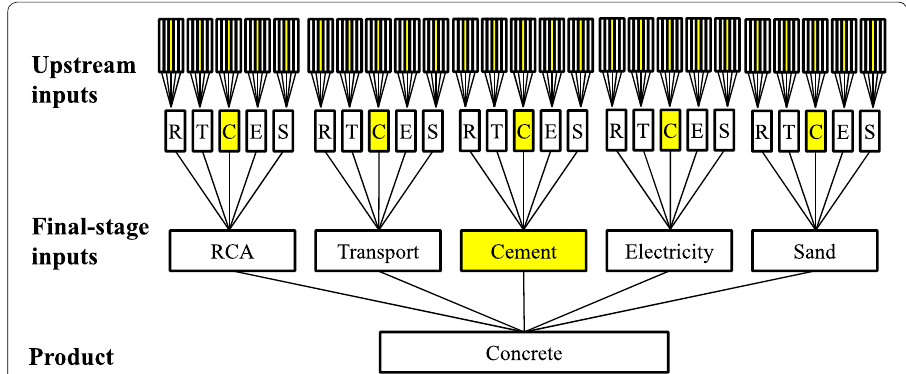
Fig. 2 LCI decomposition by origin , using the process of producing cement as an example for the ultimate origin of impacts from one particular